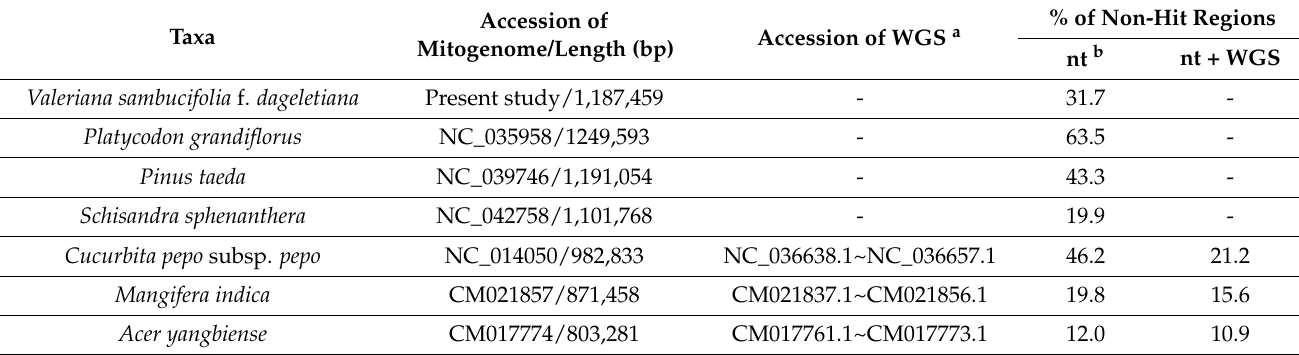
Table 2. The results of BLASTn searches for seven mitogenomes with or without whole-genome sequences. % of Non-Hit Regions Accession of Taxa Accession of WGS a Mitogenome/Length (bp) nt b nt + WGS Present study/1,187,459 - 31.7 -